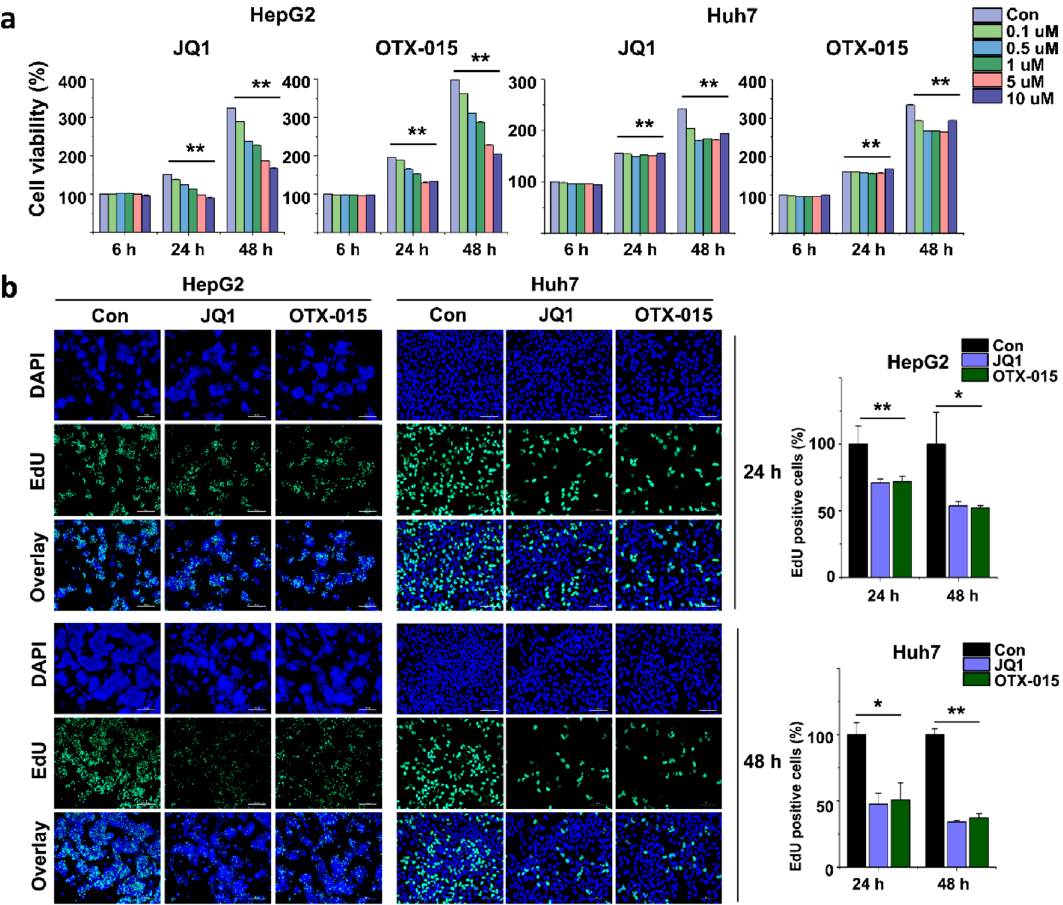
Figure 1. BET inhibition reduced cell proliferation of HCC. ( a ) HCC cell lines were treated with different concentrations of BET inhibitors (JQ1 or OTX-015) for different durations (6 h, 24 h, and 48 h). Cell proliferation was determined using a WST-1 assay. HCC cells treated with BET inhibitors were significantly reduced after 24 h of treatment. ( b ) Representative photo images of the EdU assay of HCC cells treated with BET inhibitors and quantification of EdU-positive cells. The data represent three biologically independent experiments. ** p <